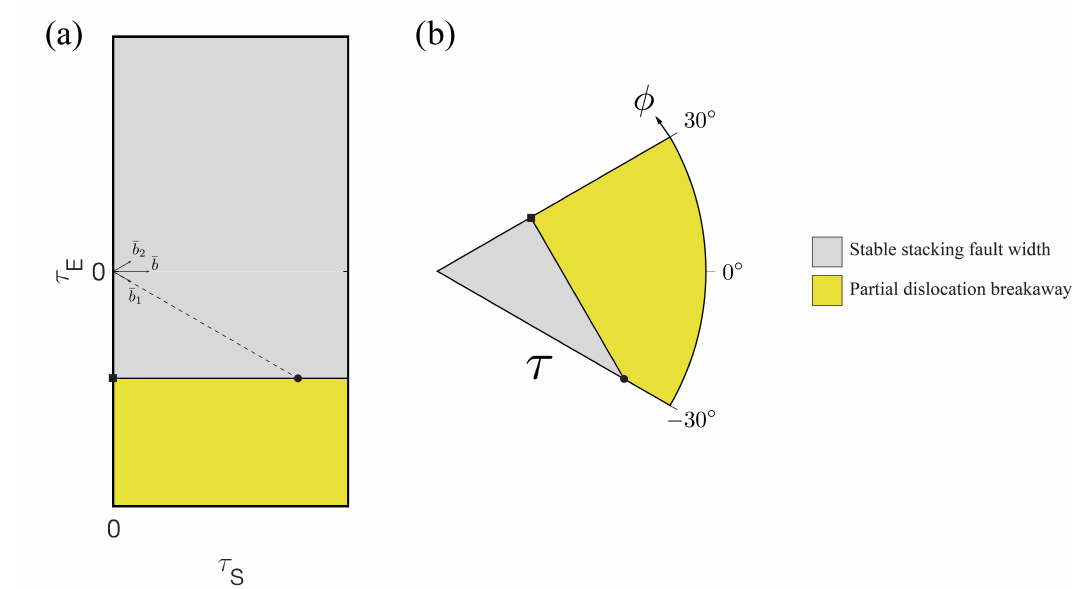
Figure 7. Orientation dependence of the Copley-Kear-Byun partial dislocation breakaway mechanism [7,36] for the extension of a stacking fault as a twin nucleus. ( a ) Schematic plot with aspect ratio 1:1 of the stress orientations where each regime would appear and ( b ) reduced map within the domain of φ . Two points are marked before and after reflecting the boundary along the − 30 ◦ axis indicated by the dashed